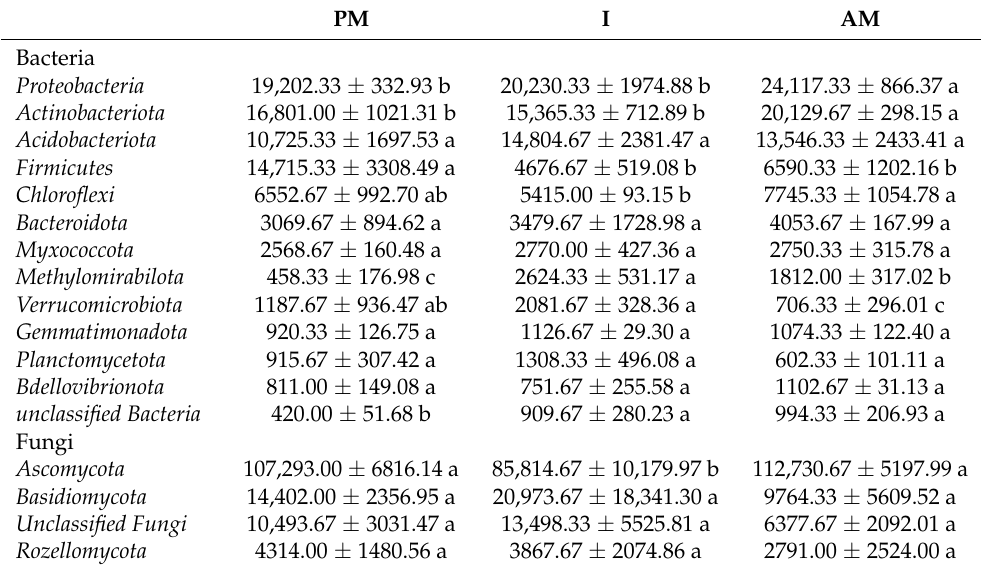
Table A1. Soil dominant microbial composition under different planting patterns (phylum level).